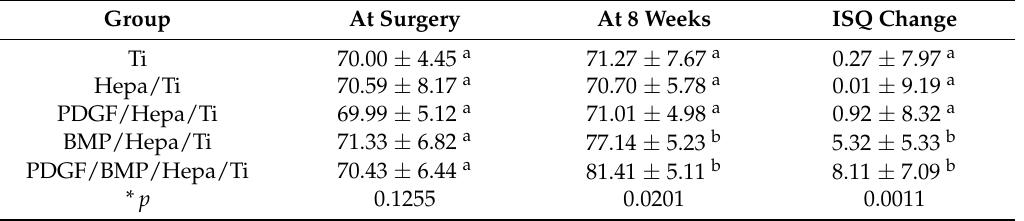
Table 2. Implant stability quotient (ISQ) values of groups immediately and 8 weeks after implantation. Group At Surgery At 8 Weeks ISQ Change Ti 70.00 ± 4.45 a 71.27 ± 7.67 a 0.27 ± 7.97 a Hepa/Ti 70.59 ± 8.17 a 70.70 ± 5.78 a 0.01 ± 9.19 a PDGF/Hepa/Ti 69.99 ± 5.12 a 71.01 ± 4.98 a 0.92 ± 8.32 a BMP/Hepa/Ti 71.33 ± 6.82 a 77.14 ± 5.23 b 5.32 ± 5.33 b 70.43 ± 6.44 a 0.1255 0.0011